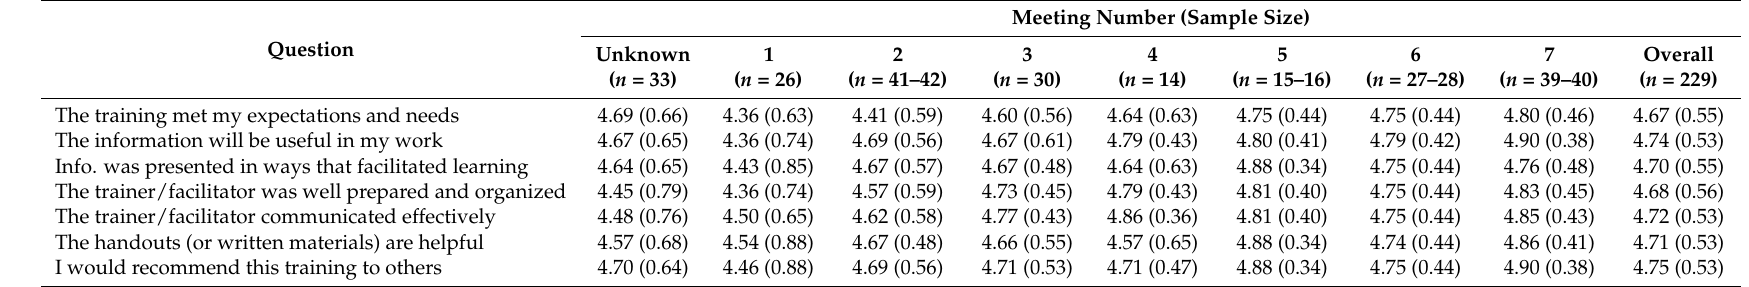
Table 4. Worker evaluations for COMPASS groups in the Oregon Home Care Commission training system: Mean ( SD ) ratings for quantitative questions in the original evaluation